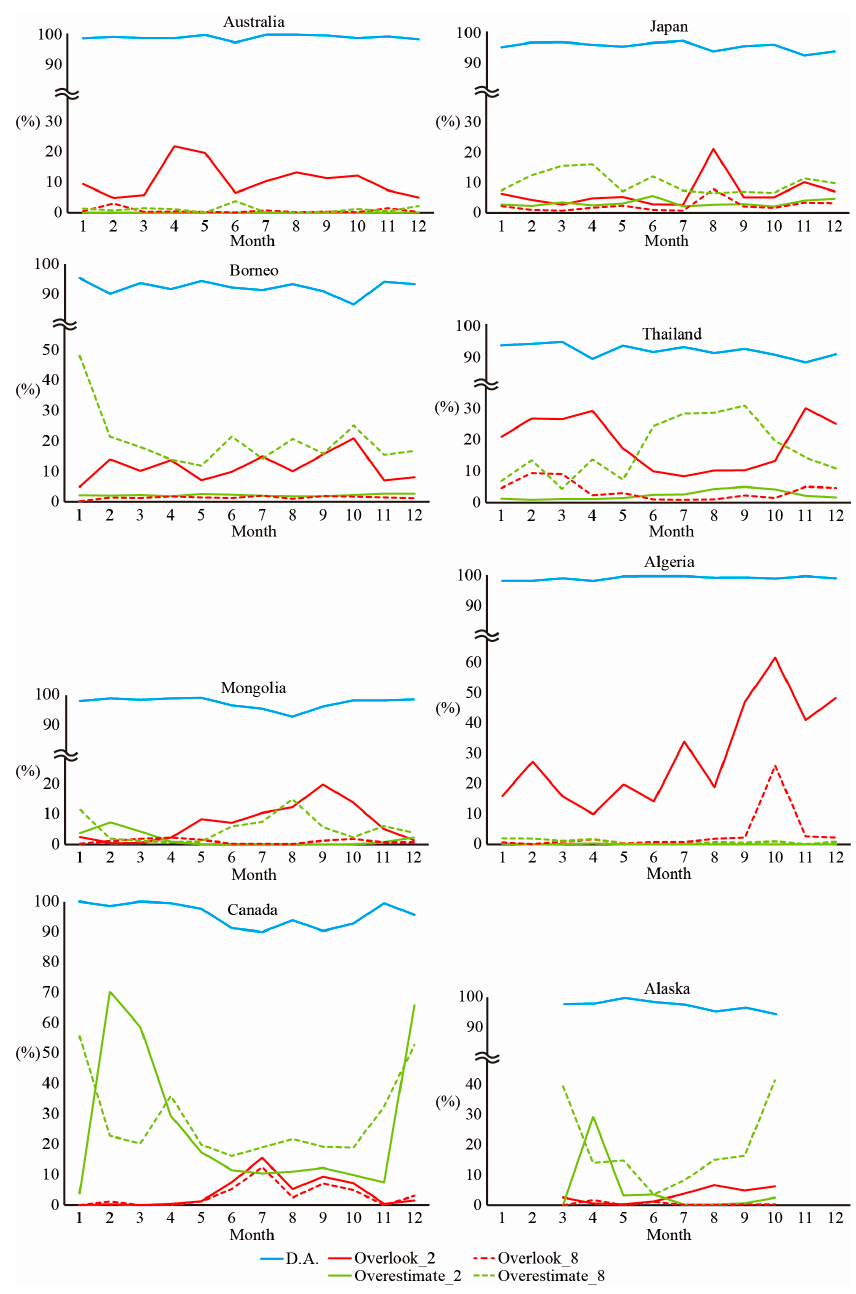
Figure 3. Monthly averages of “degree of agreement (D.A.)”, “Overlook”, and “Overestimate” in a comparative analysis using Feb-SV (February support vector) and Aug-SV (August support vector). For Overlook_2 and Overestimate_2, Feb-SV results were used as standard images, and Overlook_8 and Overestimate_8 used Aug-SV results as standard